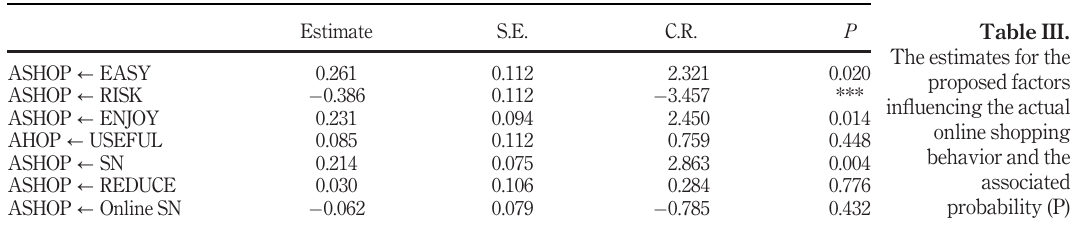
Table III. The estimates for the proposed